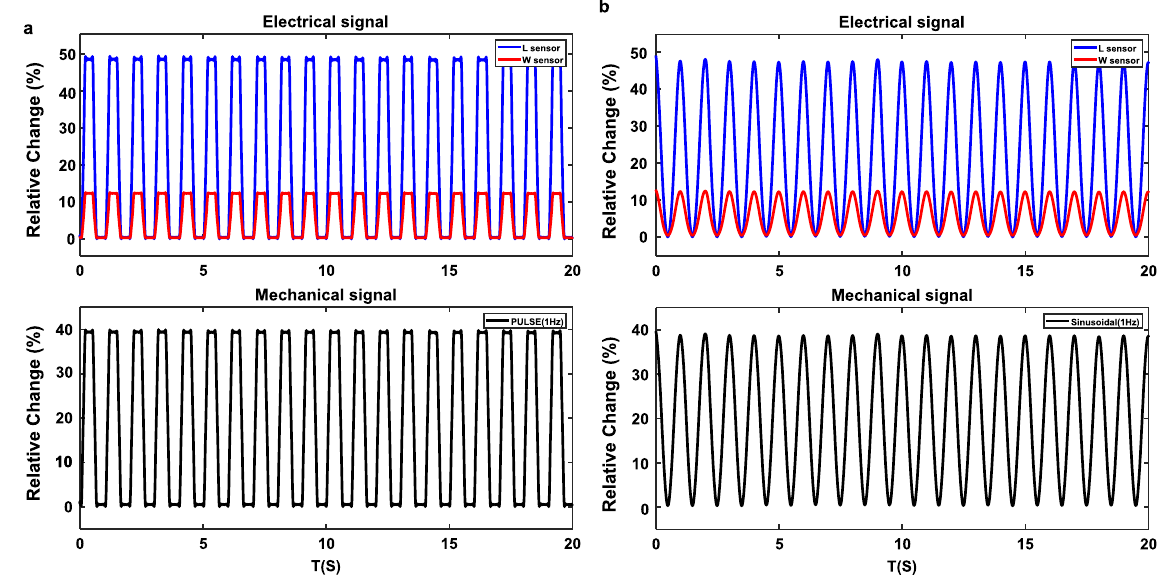
Figure 2. Simulation output of ( a ) pulse shape and ( b ) sinusoidal mechanical